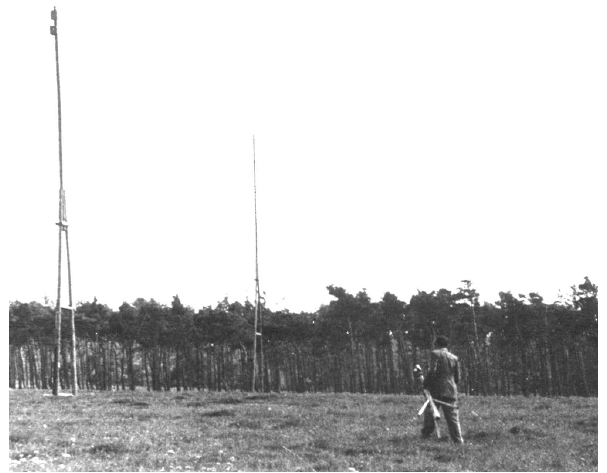
Figure 10. Erection of the first antenna masts in 1954.